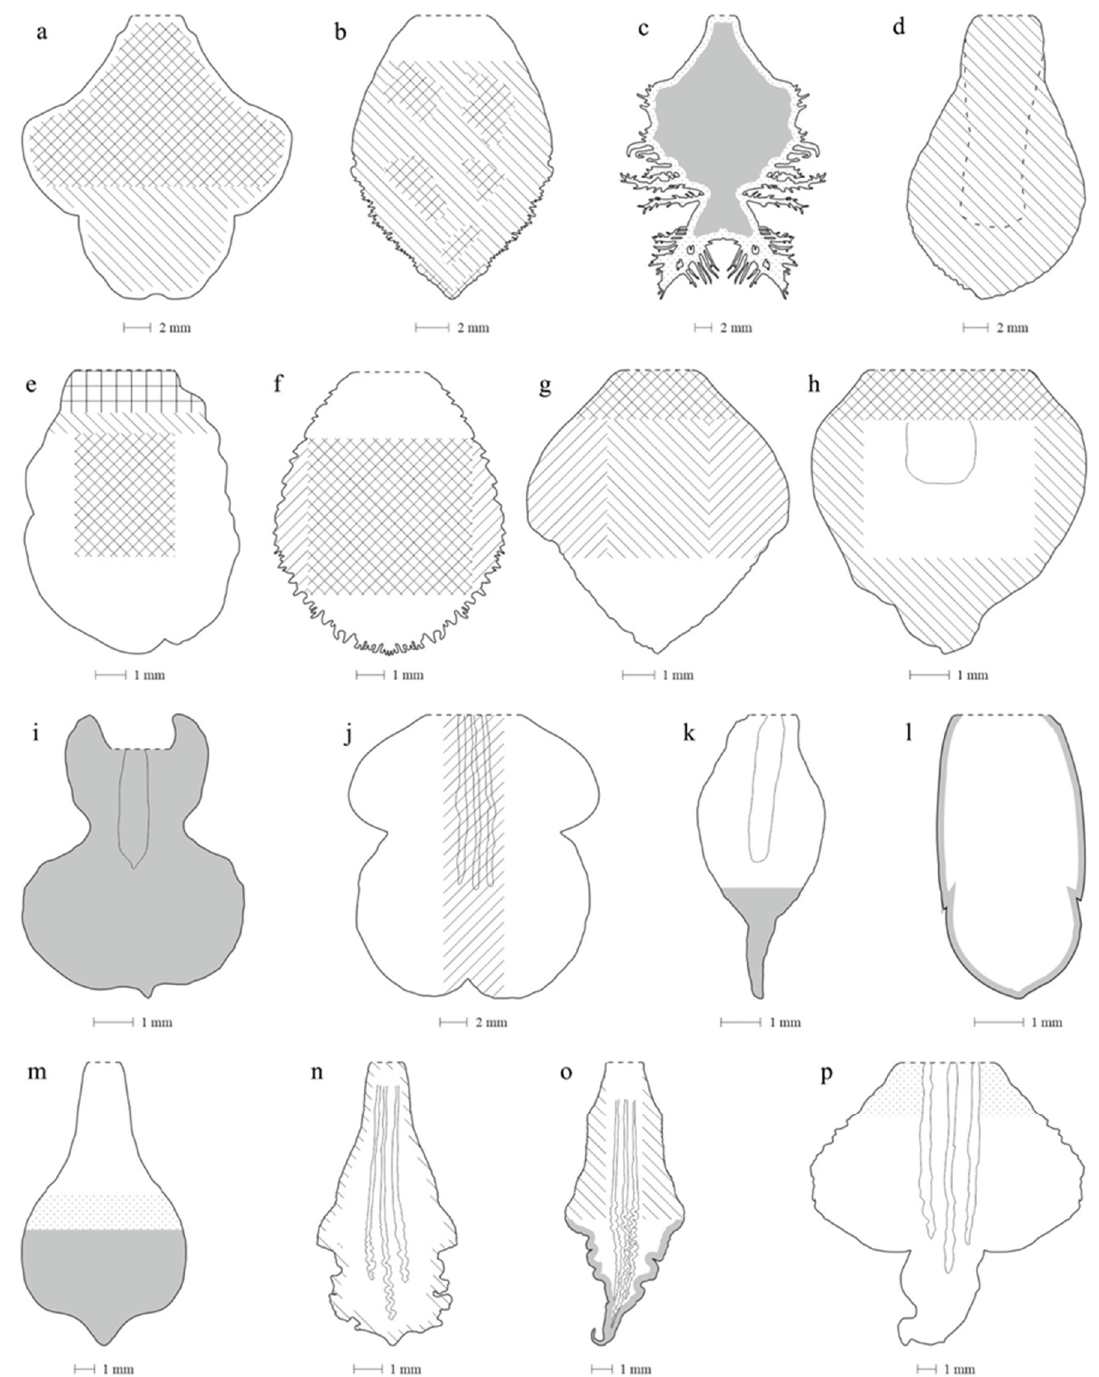
Figure 4. Relative density of trichomes and papillae on the labellum of Dendrobium : ( a ) D. hainanense ;